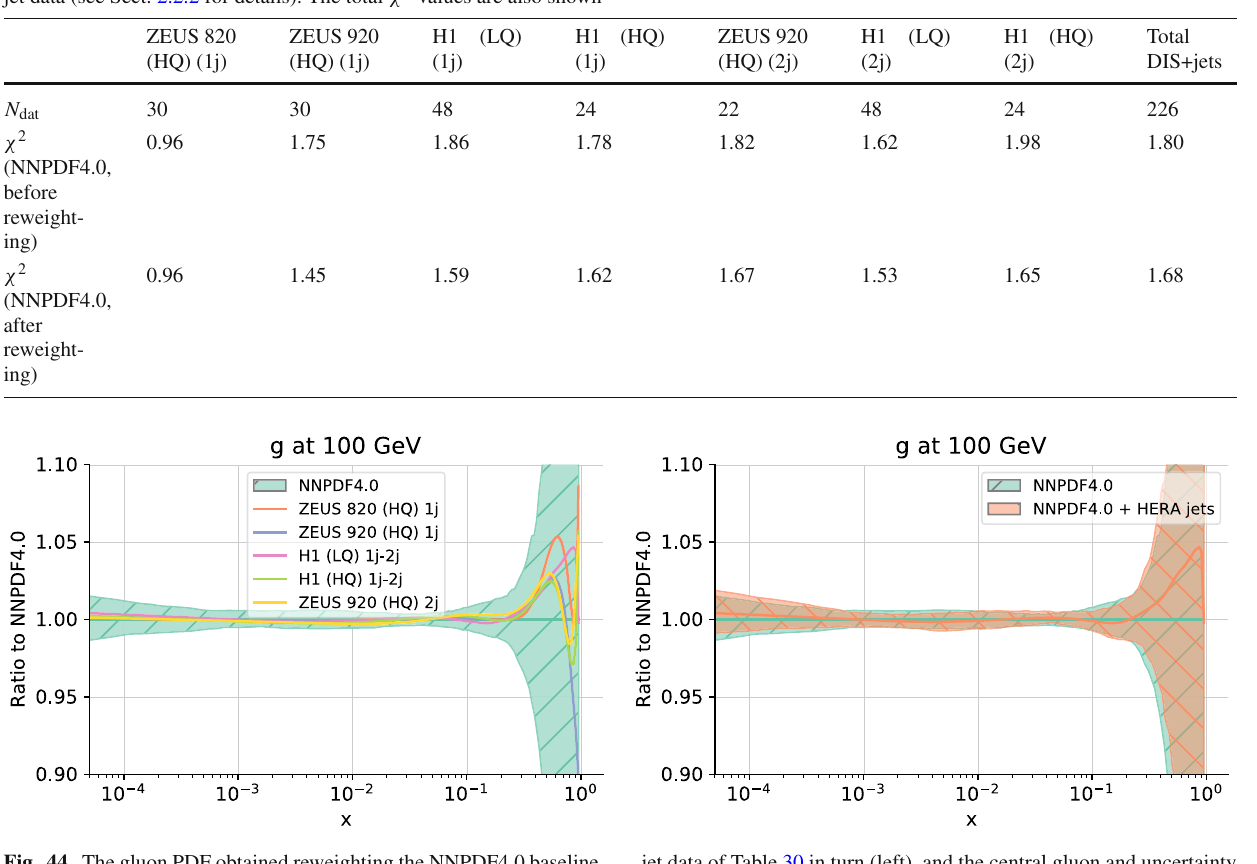
jet data of Table 30 in turn (left), and the central gluon and uncertainty obtained when reweighting with the full DIS jet dataset considered here (right)